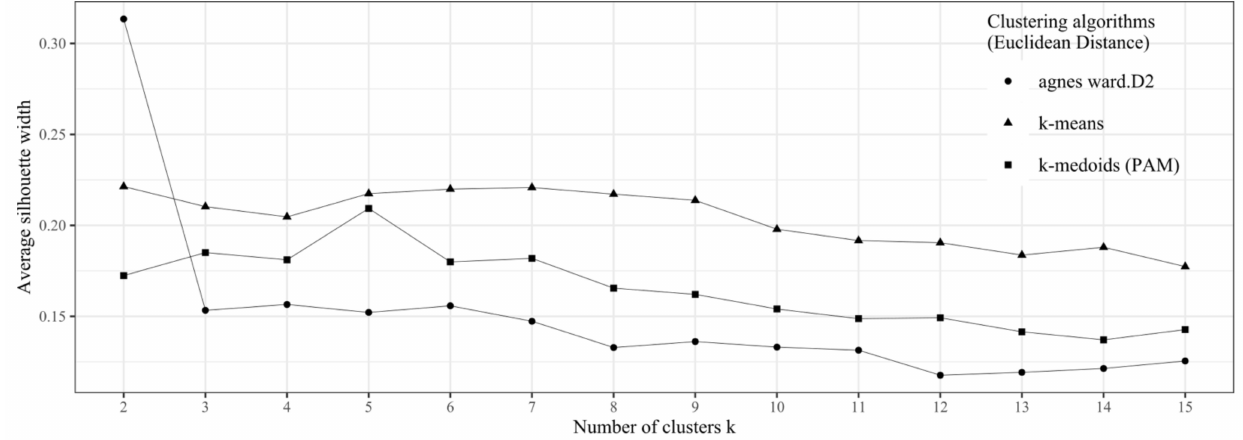
Figure 3. The mean silhouette value depending on the algorithm and k (the higher the better).